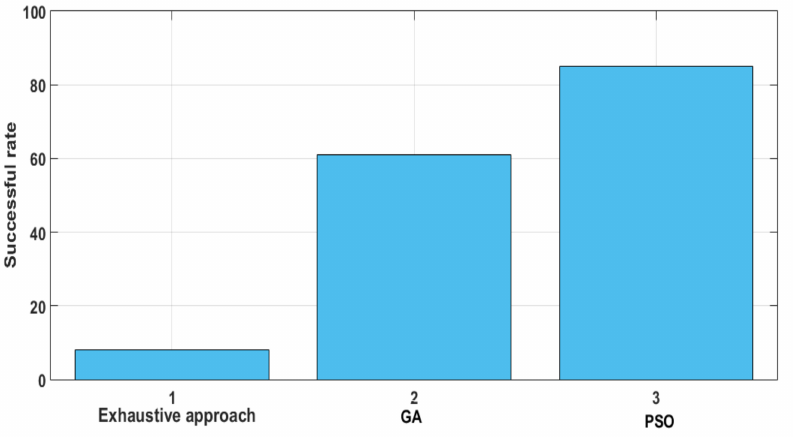
Figure 11. The comparison of the successful rate of the proposed methods for IEEE 33-bus test system.